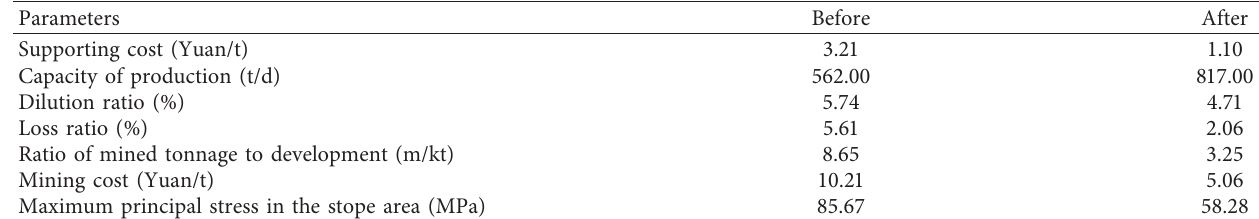
Table 6: Comparison of the economic index of before and after the unloading mining.